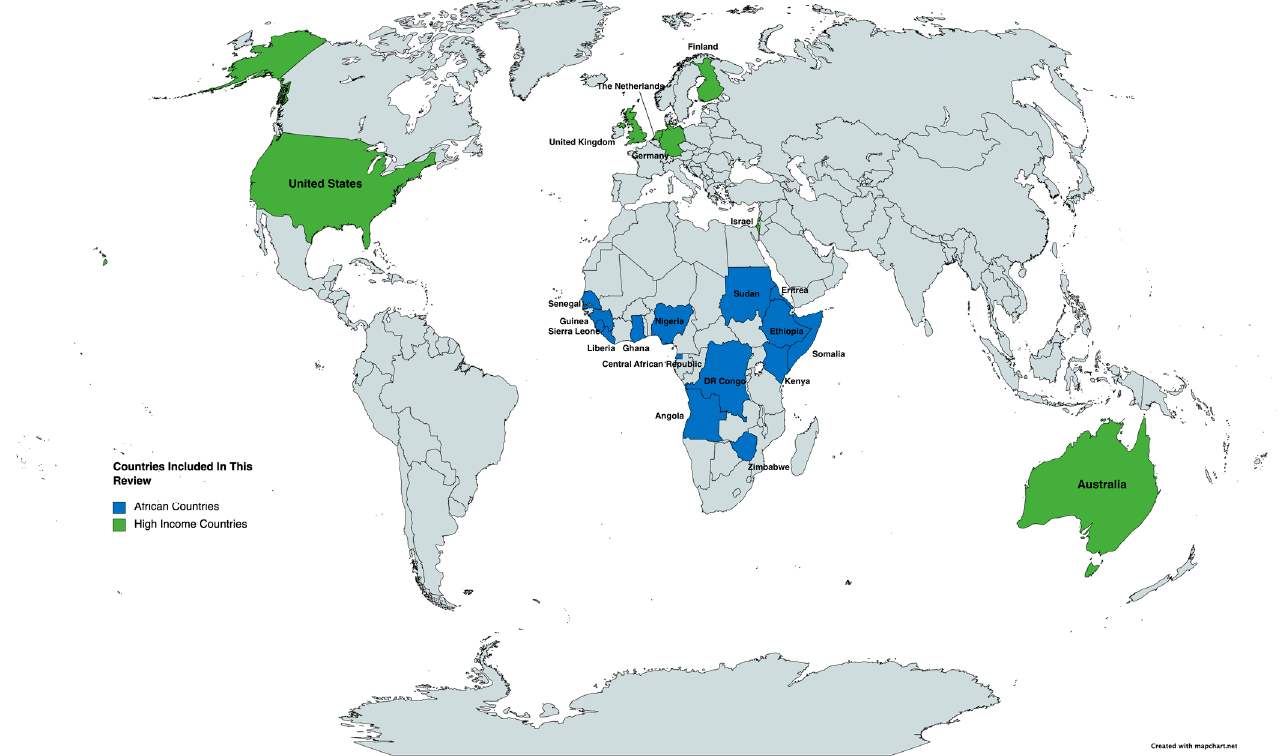
Figure 2. African Countries of Origin. Note, Somaliland is not distinguished from Somalia.